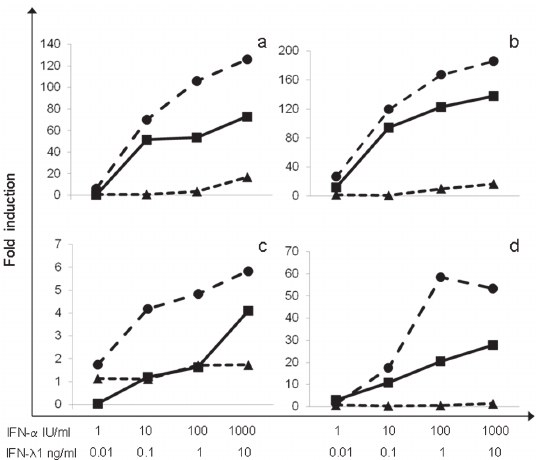
Fig 2. Dose-dependent induction of MxA and 2 ’ -5 ’ OAS mRNA levels following treatment with recombinant IFN- α , IFN- λ 1 and IFN- α +IFN- λ 1. A549 (a), (c) and HuH7 cells (b), (d) were exposed 3h to increasing amounts of either IFN type, alone or in combination, then mRNA levels for MxA (a), (b) and 2 ’ - 5 ’ OAS (c), (d) were measured, expressed as fold induction vs. untreated cells. One out of three experiments is shown. Dotted lines: IFN- α ( ● ) or IFN- λ 1 ( ▲ ) used alone; continuous line: IFN- α and IFN- λ 1 ( ■ ) used in combination.